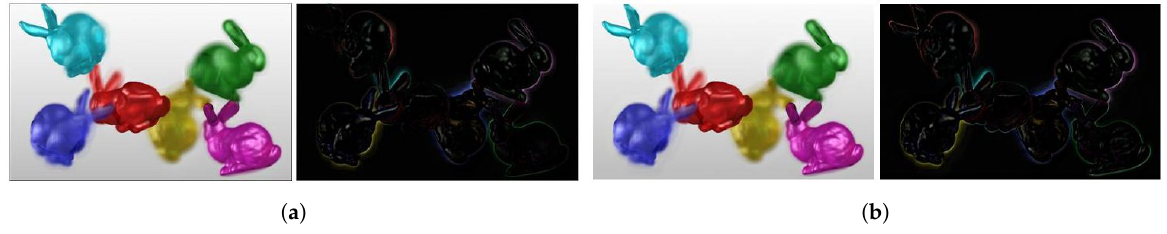
Figure 16. View 19 of Bunnies reproduced using analytical (ANA) and CNN-based (CNN) optimization of multiplicative layers, with corresponding difference images. ( a ) ANA: Reproduced view and error, PSNR: 19.94 dB, SSIM: 0.895; ( b ) CNN: Reproduced view and error, PSNR: 22.18 dB, SSIM: